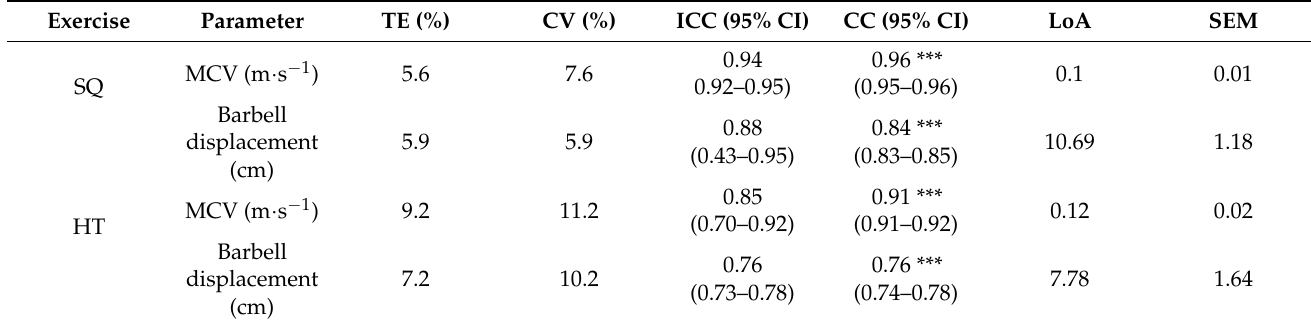
Typical error of measurement (TE), coefficient of variation (CV), intraclass correlation coefficient (ICC), Pearson correlation coefficient (CC), limit of agreement (LoA) and standard error of measurement (SEM). Pearson correlation significances are given as *** p <